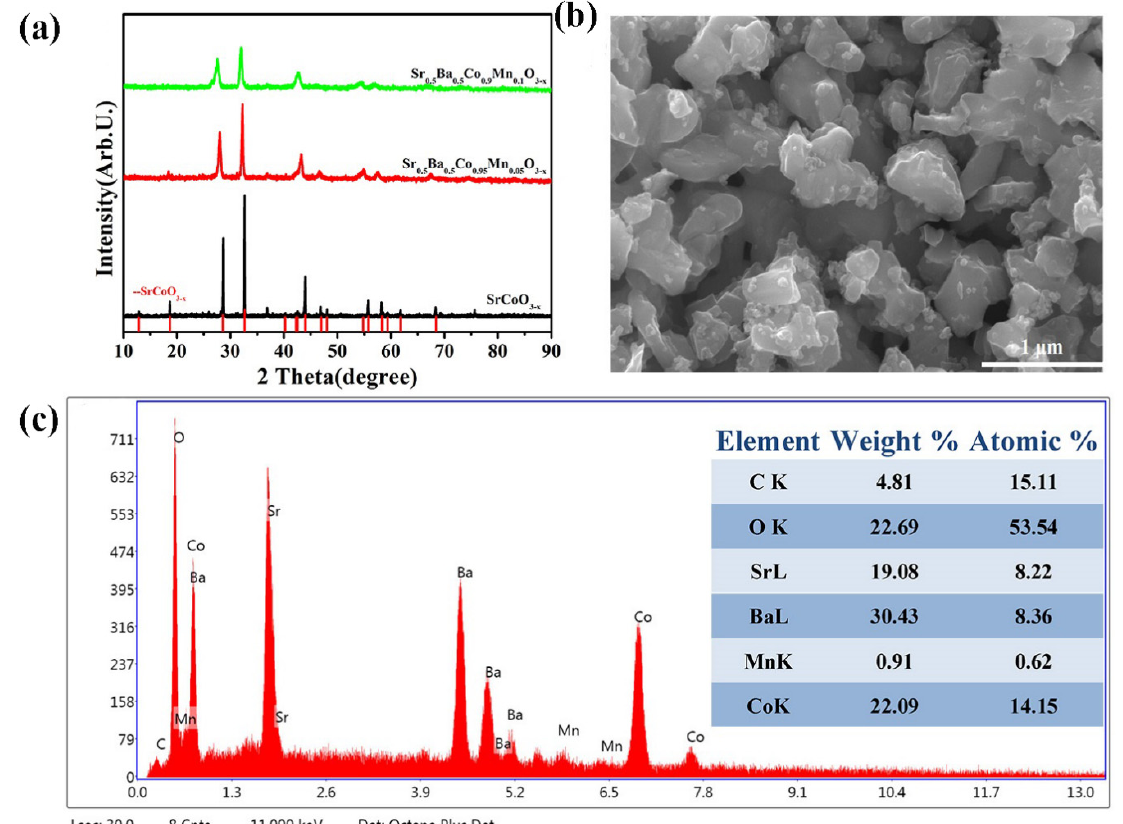
Figure 5. ( a ) XRD pattern; ( b ) SEM image and ( c ) EDS energy spectrum of Sr 0.5 Ba 0.5 Co 0.95 Mn 0.05 O 3 − x.